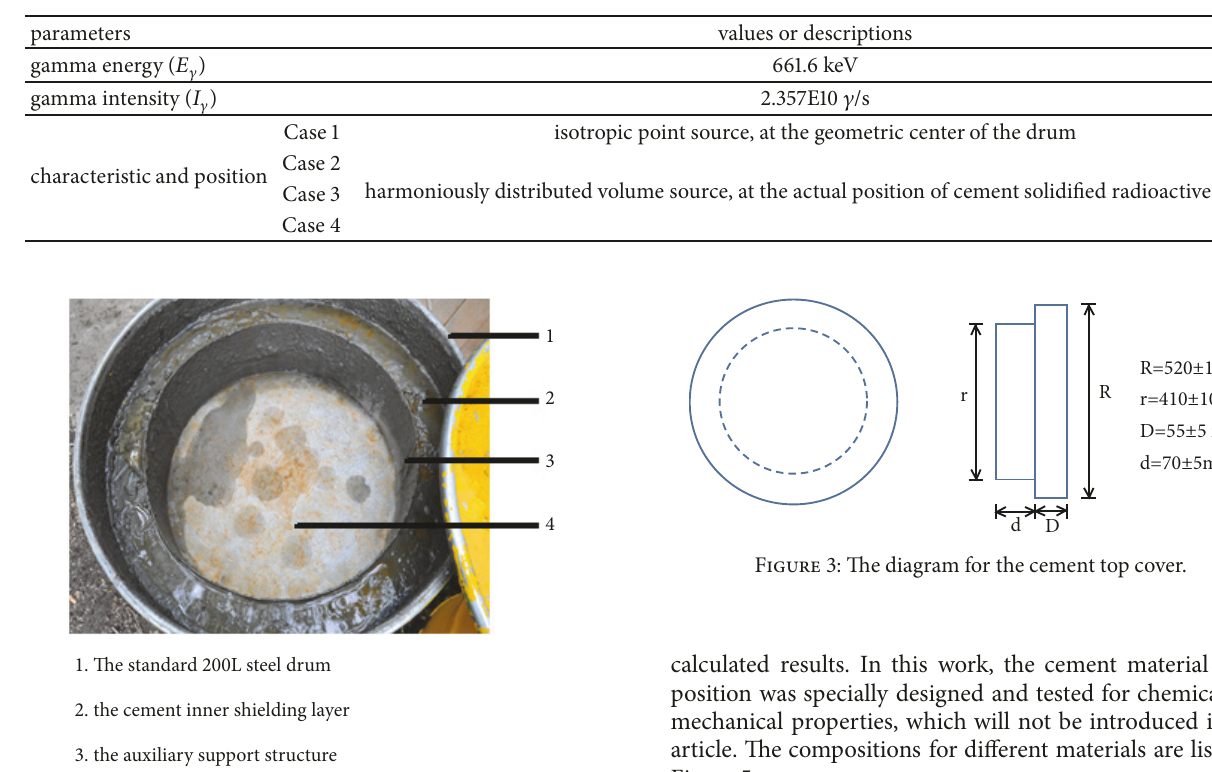
Table 1: The input parameters of source term in FLUKA and QAD-CGA.